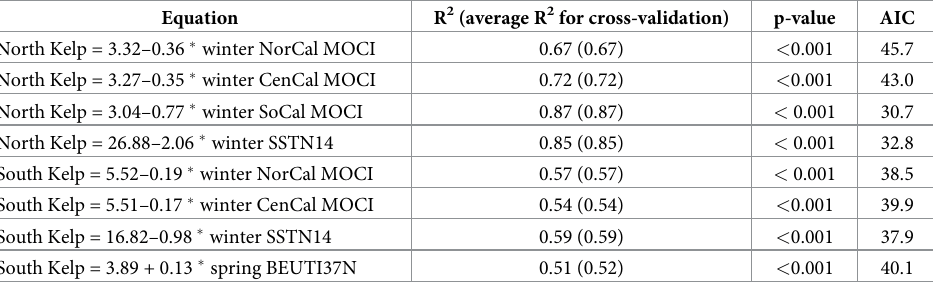
Table 2. Selected regression models of summer kelp canopy